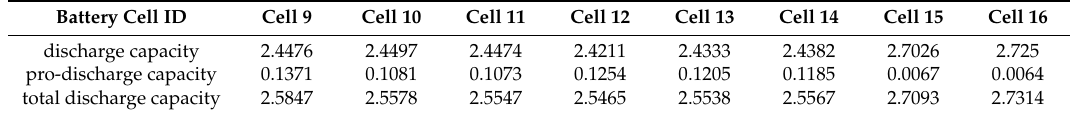
Table 3. The discharge capacity and pro-discharge capacity of batteries.